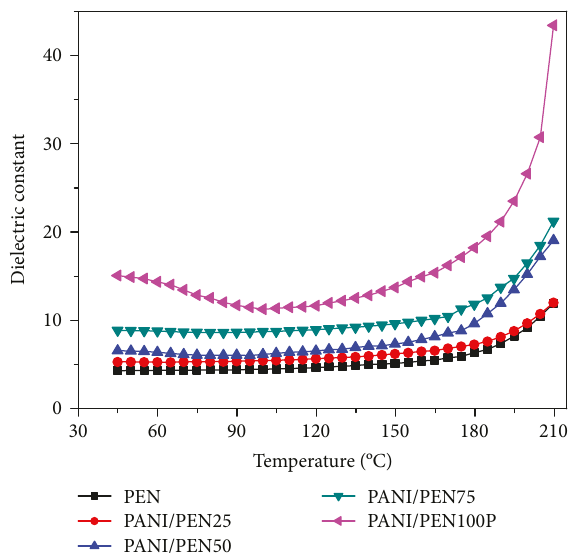
Figure 4: Dielectric permittivity-temperature dependences of PEN/ PANI composites at 1kHz. (PEN, PANI/PEN25, PANI/PEN50, PANI/PEN75, and PANI/PEN100 represent the composites with 0, 2.5, 5.0, 7.5, and 10 wt% of PANI,